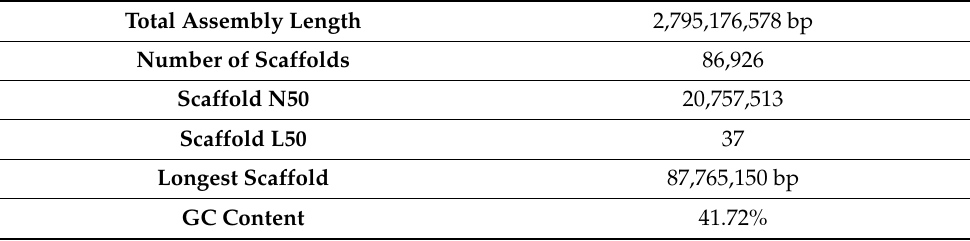
Table 3. Scaffold statistics of the addax in silico mate pair assembly with QUAST v5.0.2.